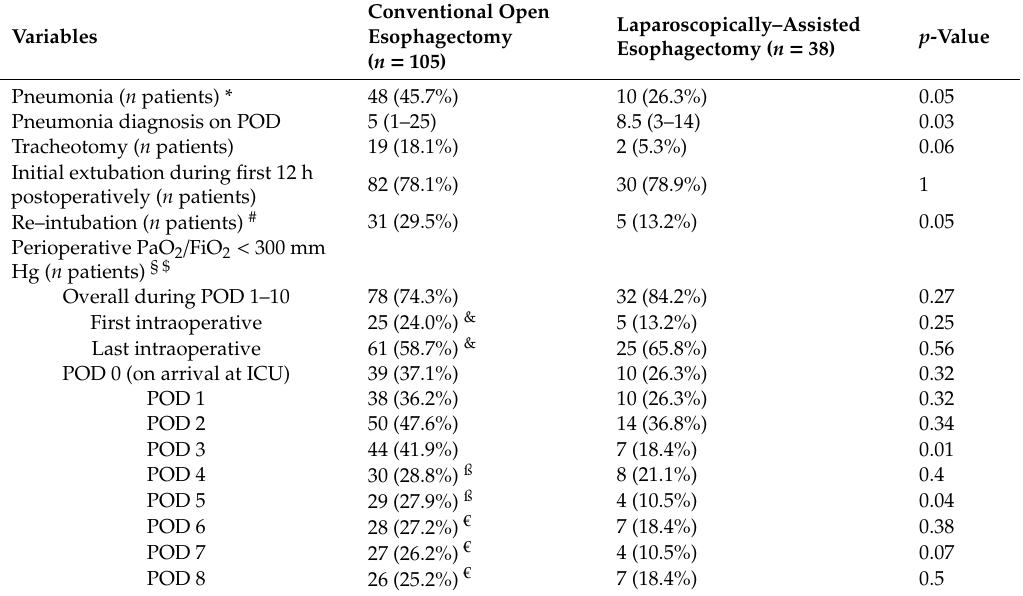
Figure 1. Kaplan-Meier estimation of cumulative incidences of postoperative pneumonia. Black line: conventional open abdomino-thoracic esophagectomy (OE)-group, n = 105 patients. Gray line: hybrid minimally invasive, laparoscopically assisted abdomino-thoracic esophagectomy (LAE)-group, n = 38 patients. Patients, who were discharged, died, or suffered from re-do (revision) surgery were censored from the analysis of cumulative incidences since the day of the event. Censored data are indicated in the figures by vertical ticks. * indicates differences in the cumulative incidence of postoperative pneumonia between both groups at postoperative day 30 ( p = 0.01). Table 5. Pulmonary outcome.